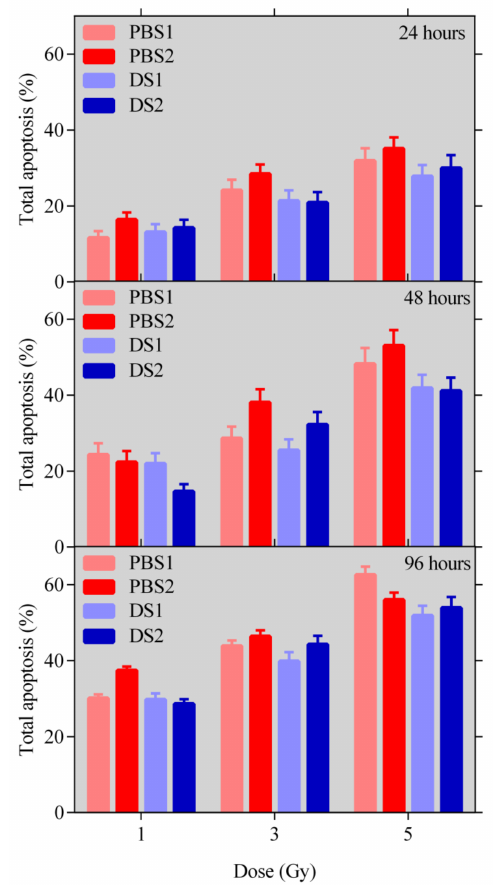
Figure 3. The percentage of Caspase 3 / 7-positive cells undergoing apoptosis (total apoptosis = early + late) determined for the two modes and two positions at three di ff erent periods of time post irradiation. No statistically significant di ff erences have been found using the t